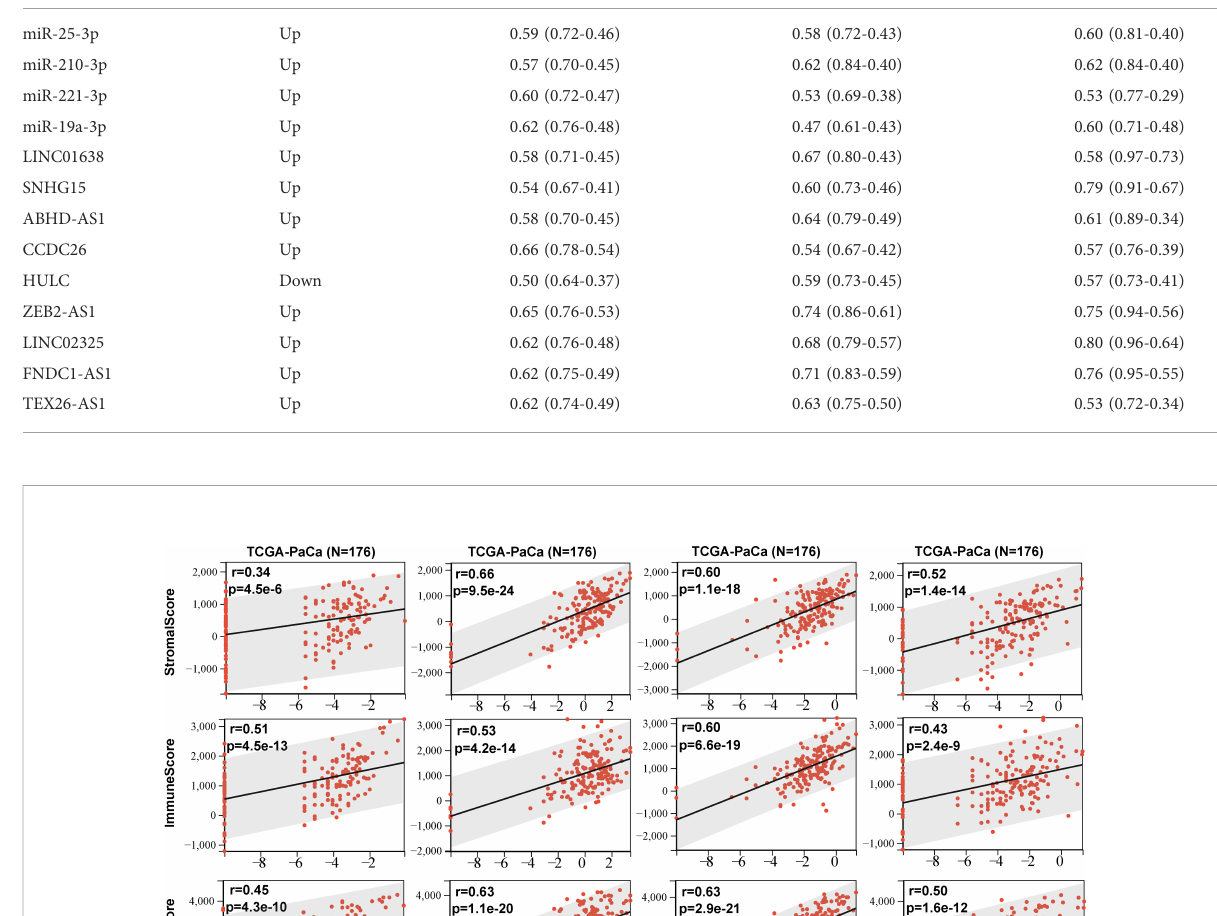
TABLE 3 The prognostic value of other candidate markers and four IRlncRNAs for pancreatic cancer survival analysis. Candidate marker